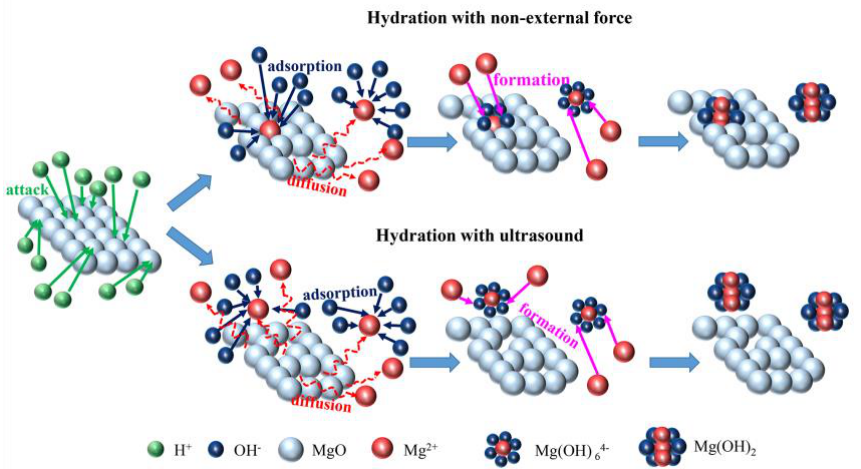
Figure 8. The mechanism of MgO hydration.